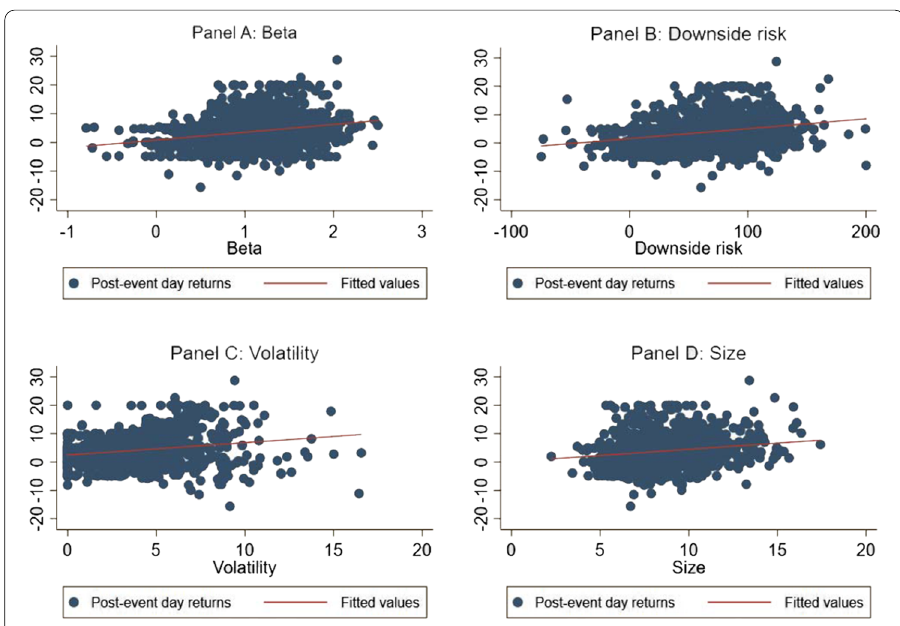
Fig. 2 Heterogeneous effect of the event. Note : This figure shows the relationship between post-event returns and stock characteristics such as beta, downside risk, volatility and size in Panel A, B, C, and D